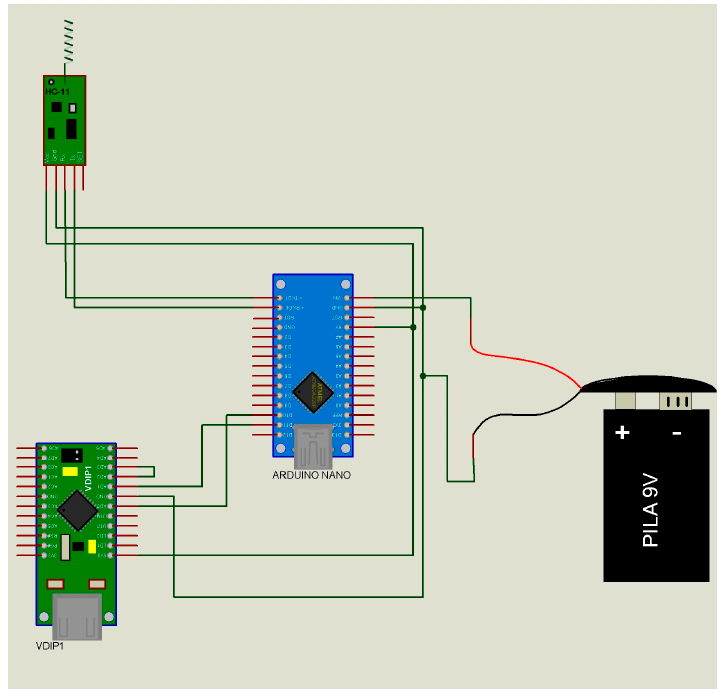
Figure 4. Schematic diagram of the data receiver/transmitter module or “supervisor”. Receiver mode: file of people found by the master modules (Table 4 (A)). Transmitter mode: missing people file sent to the master modules (Table 4 (B)). Figure taken and adapted from Polanco et al. [5].